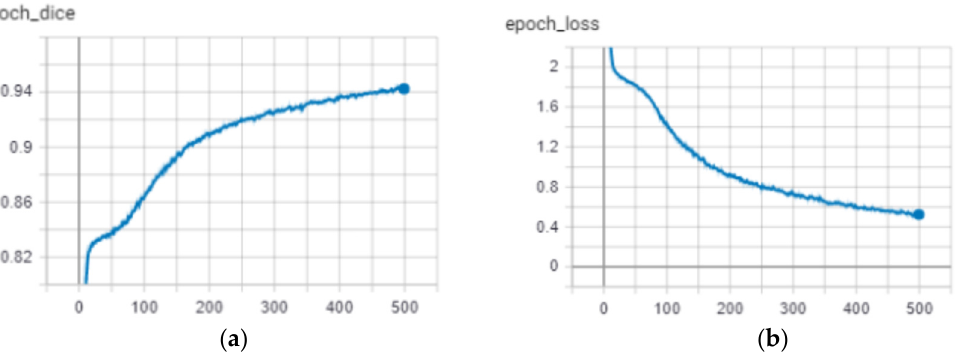
Figure 9. Dice score ( a ) and loss ( b ) for the proposed model with the Adam optimizer for the epoch count of 500.